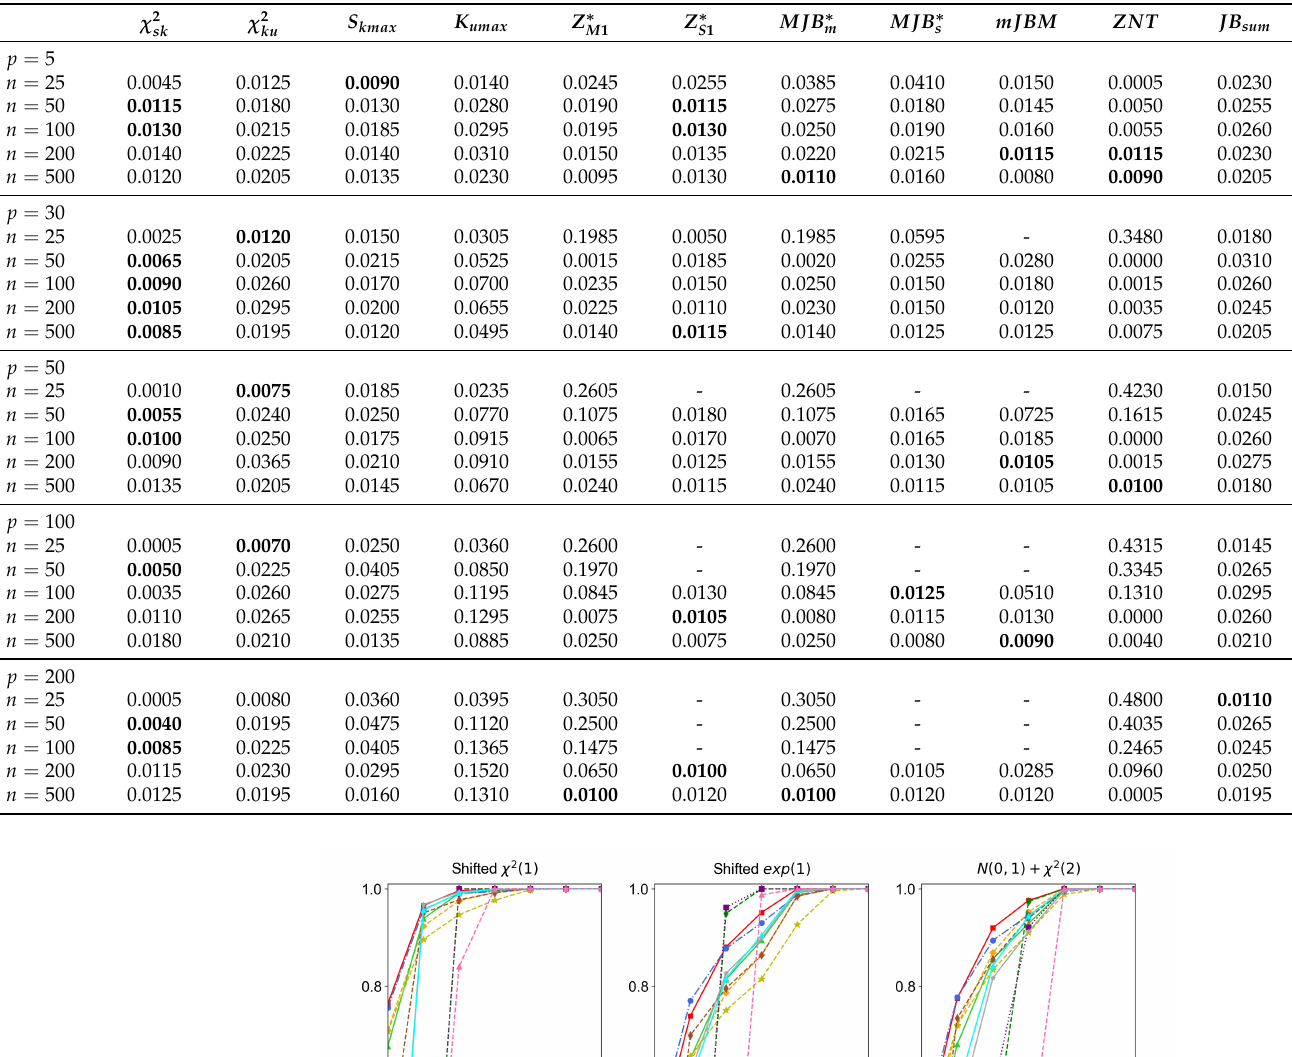
Table 4. Empirical power of PC-type Jarque–Bera (JB) testing for normally distributed data for Case-II compared with other methods ( α = 0.01).